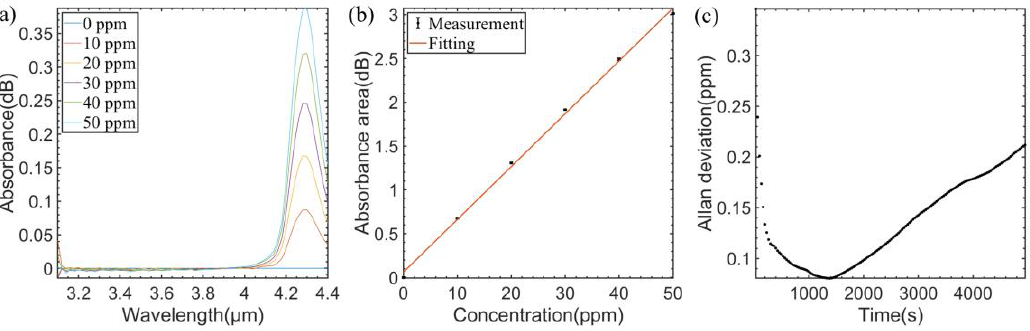
Figure 5. ( a ) Measured absorption spectra of different CO 2 concentrations. ( b ) Experimental data and fitting curve of CO 2 concentration versus absorbance area. ( c ) Allan variance analysis of the sensor for CO 2 .